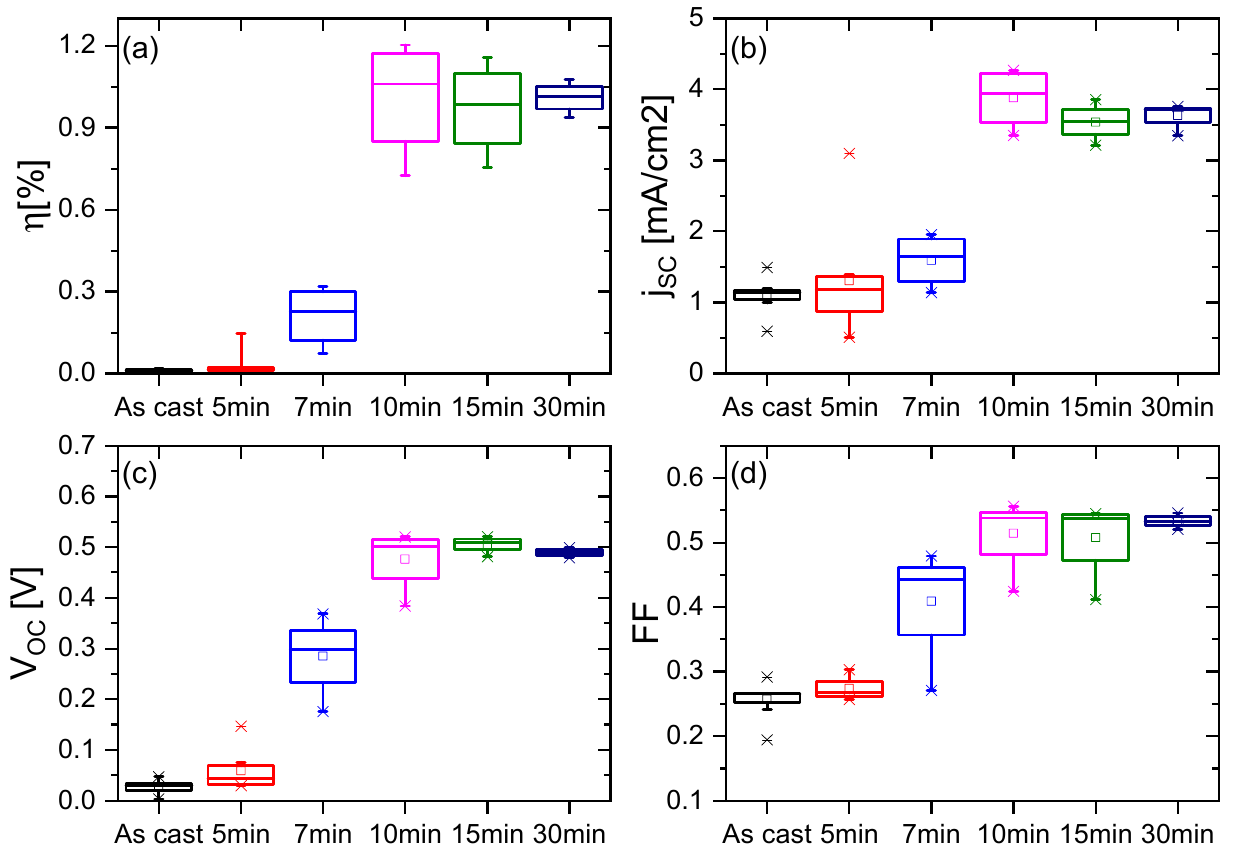
Figure 8. Performance of solar cells prepared by solvent vapor annealing of PC 60 BM/P3HT bilayers. ( a ) power conversion efficiency; ( b ) short-current density; ( c ) open circuit voltage; ( d ) fill-factor.